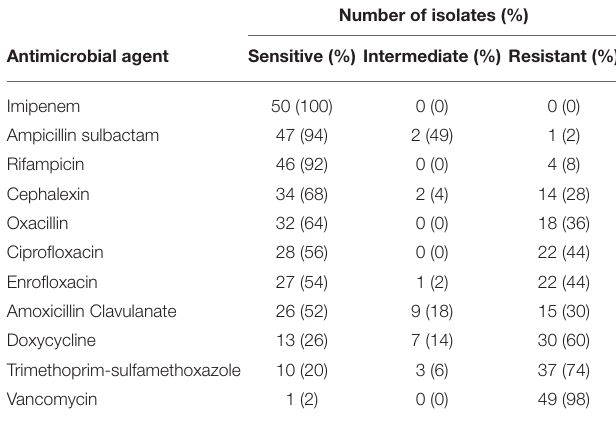
Number of isolates (%)